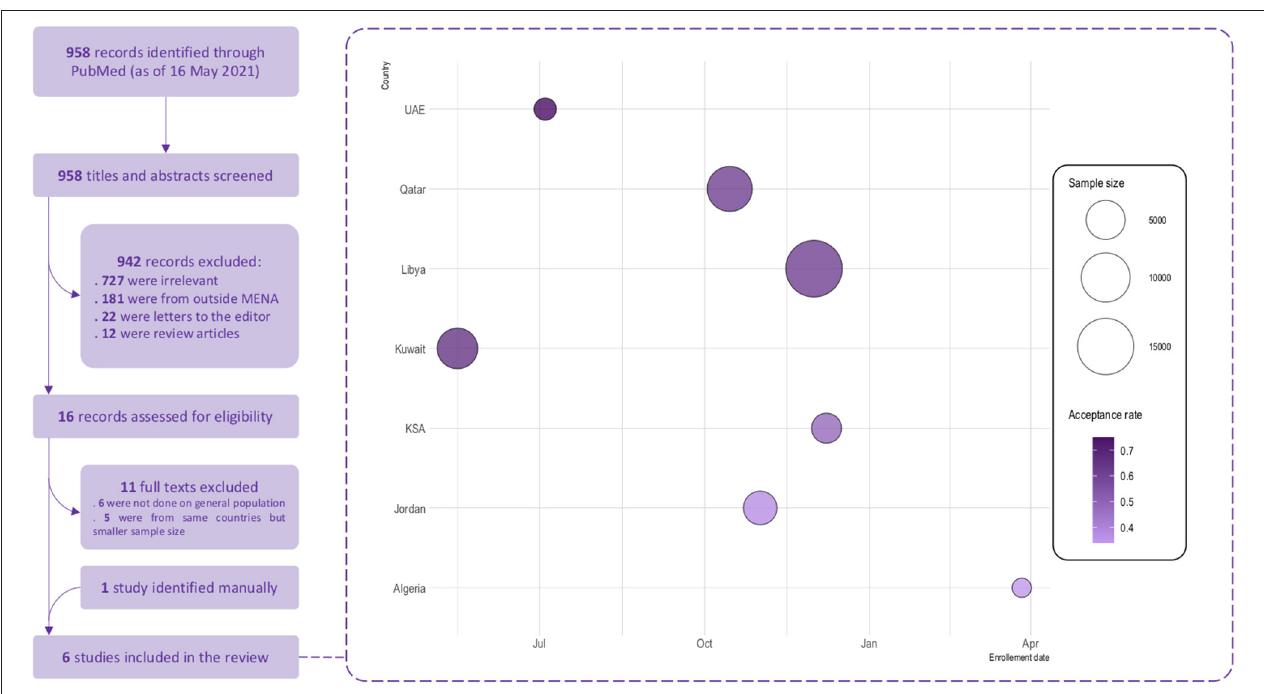
FIGURE 1 | COVID-19 vaccine acceptance in the Arab countries from the MENA region–Systematic review flowchart and findings. Size of the bubbles represents the sample size used and the color gradient represents the acceptance rate of vaccination reported in each study; light colors represents lower acceptance rates and dark colors represents higher acceptance rates. Enrollement date is the starting date of data